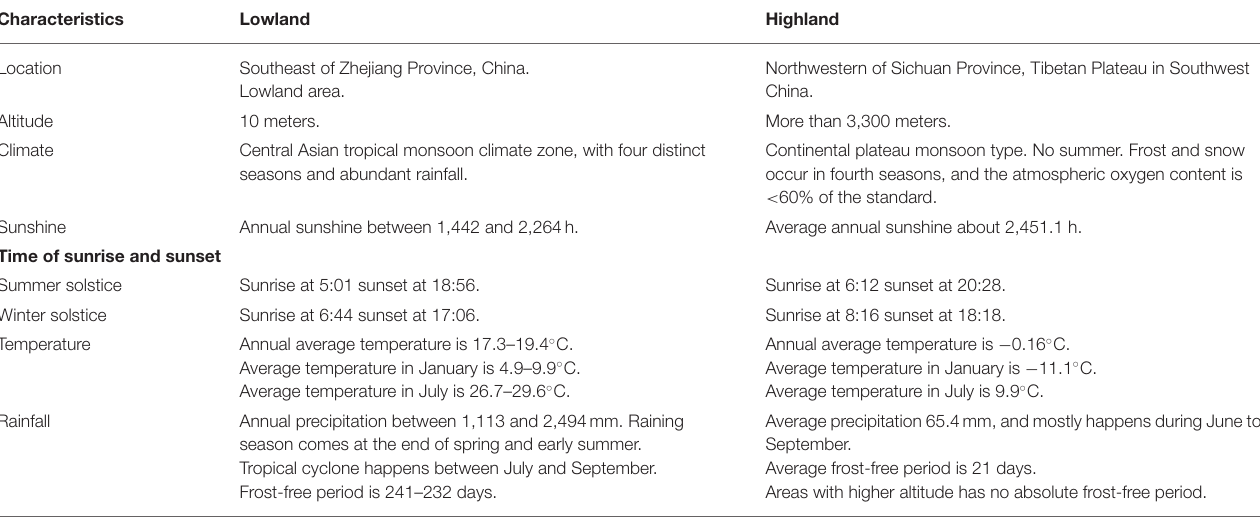
TABLE 4 | Comparisons of regional characteristics of lowland and highland